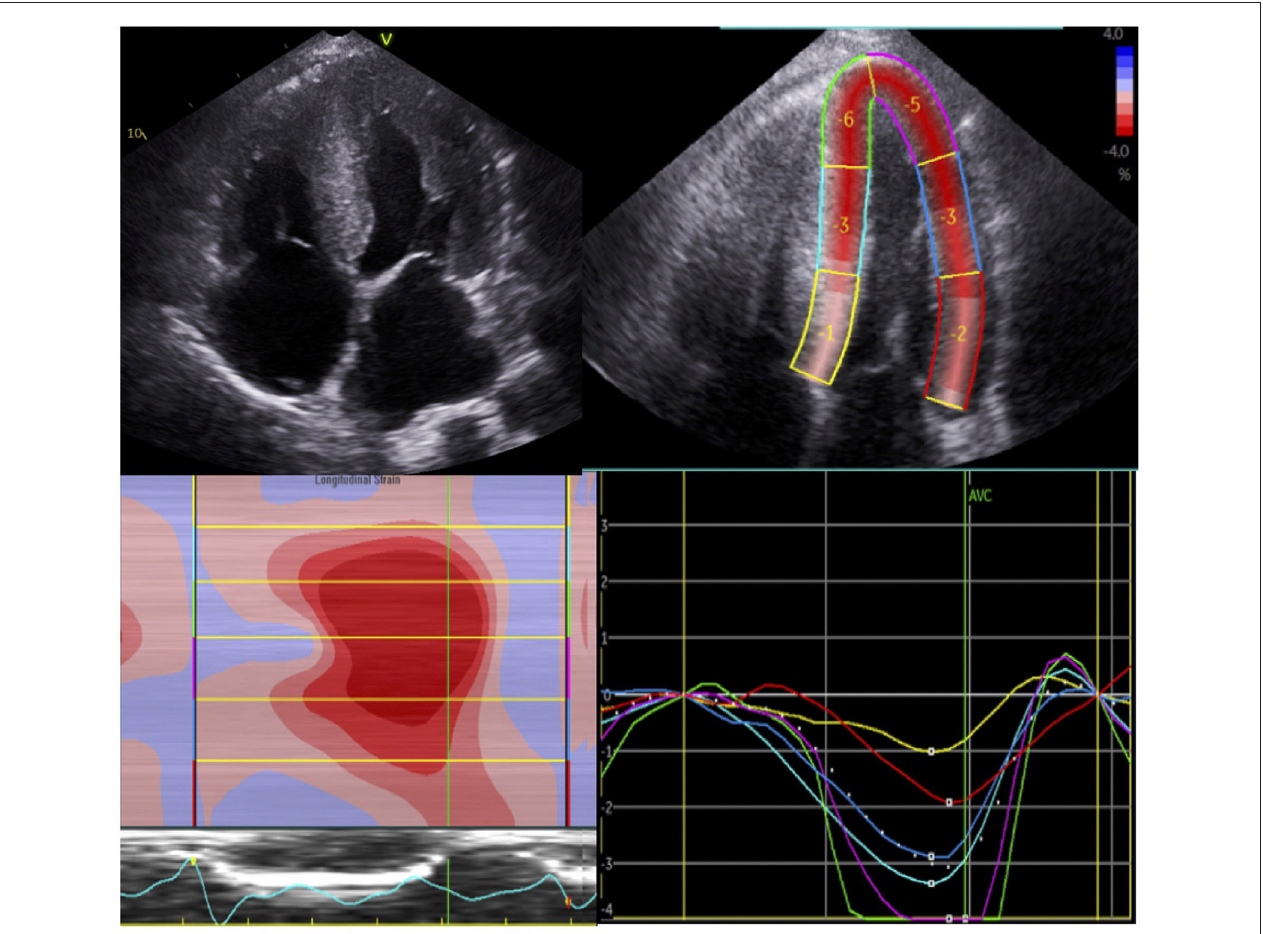
FIGURE 1 | Echocardiographic findings in a patient with advanced transthyretin cardiomyopathy. Four chamber view demonstrating increased biventricular thickening with a “speckled” myocardium (top left panels) with 2D-strain using speckle tracking echocardiography in the same patient (top right panel). Peak systolic strain for individual myocardial segments in the four-chamber view panel and the strain curve samples in each of the corresponding colored myocardial segments panel can then generate a longitudinal strain map (bottom). With an estimated GLS of − 4.3%, the characteristic basal to apical gradient of impaired longitudinal function is observed